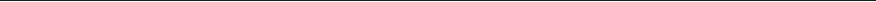
Table 1. PubMed search strategy.